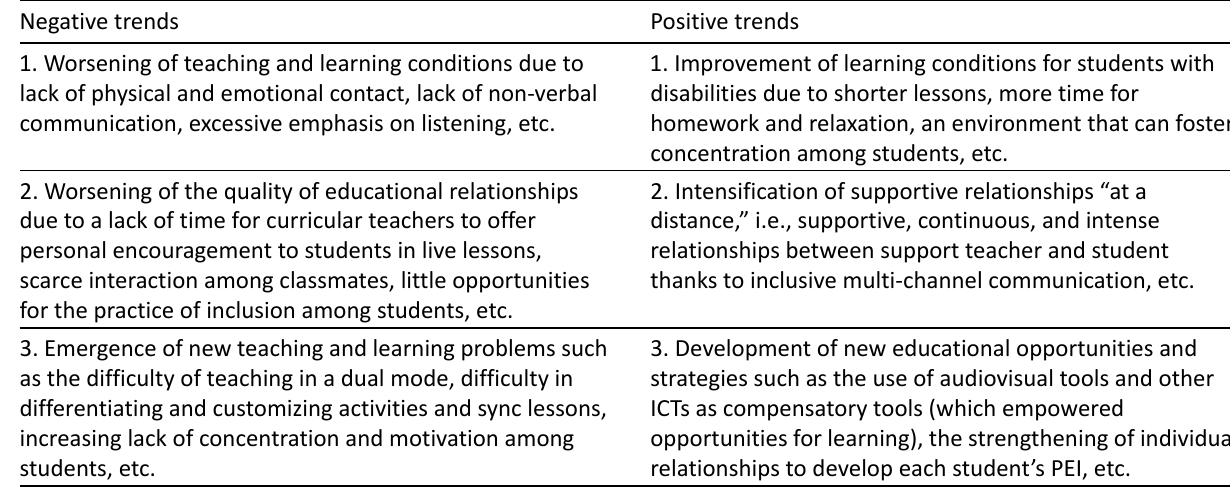
Table 3. Negative and positive trends emerging from teachers’ opinions on their experience with students with disabilities during Covid‐19 (analytical